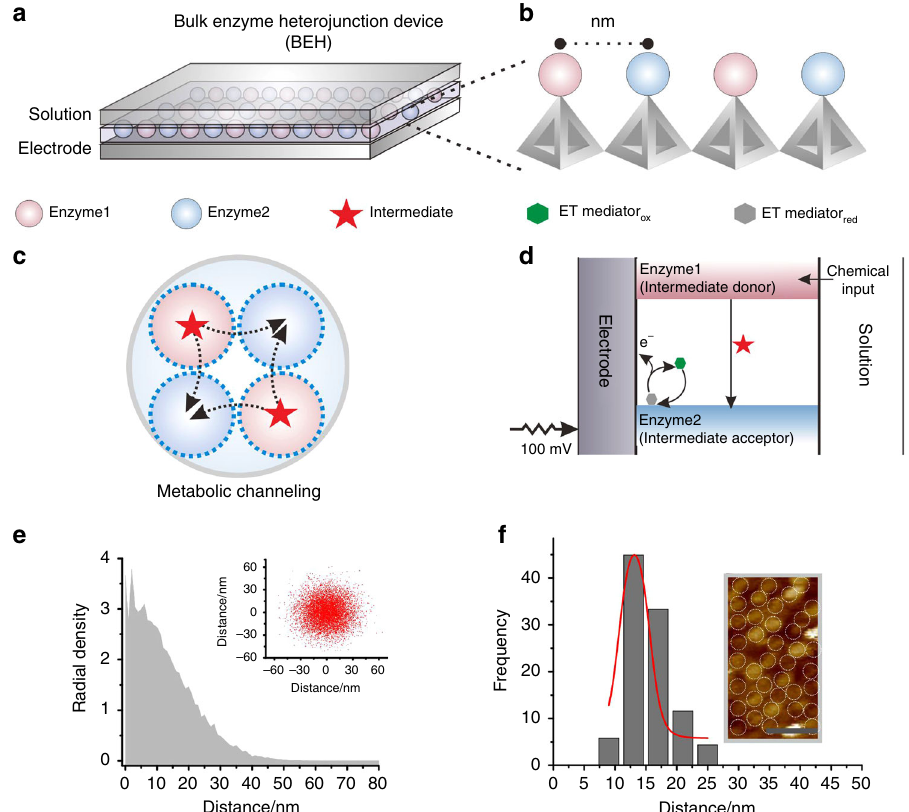
Fig. 1 TDN-programmed BEH interface for biosensor development. a Schematic representation of the BEH strategy for enhanced the enzyme cascade reaction at the gold electrode interface. b The TDN scaffolds programmably regulate the inter-enzyme distance in BEH. c Substrate channeling in BEH that support ef fi cient cascade among the enzyme pair (E1/E2) that are positioned with TDN scaffolds. d Working principle for BEH-based electrochemical biosensor device. The small molecule is oxidized by E1, producing an intermediate that diffuses to E2. As a result, electrocatalytic currents are observed at the electrode when potential is poised. e The radial density (molecule number in the area of 1 nm 2 ) distribution of intermediate, as calculated from a random walk simulation. Inset: scatter chart of the distribution of intermediate. f Statistical results of the inter-enzyme distance of BEH, and corresponding AFM image of the enzymes at the interface. Scale bar: 50 nm. Source data are provided as a Source Data fi